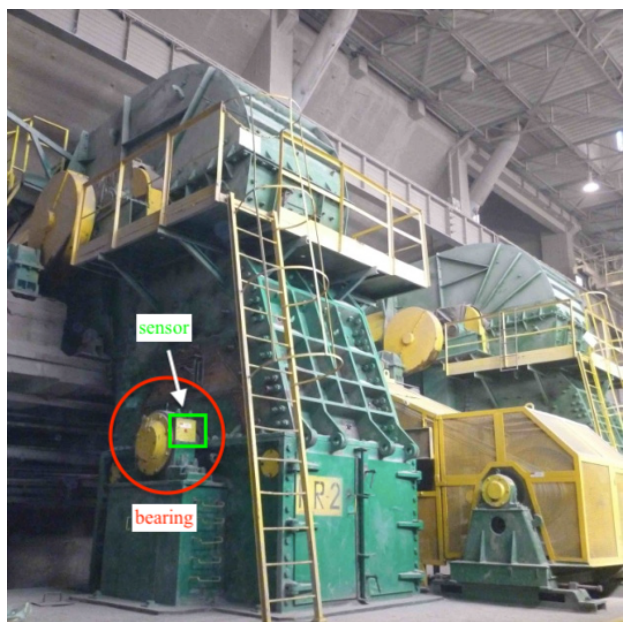
Figure 13. Hammer crusher with bearing and sensor location